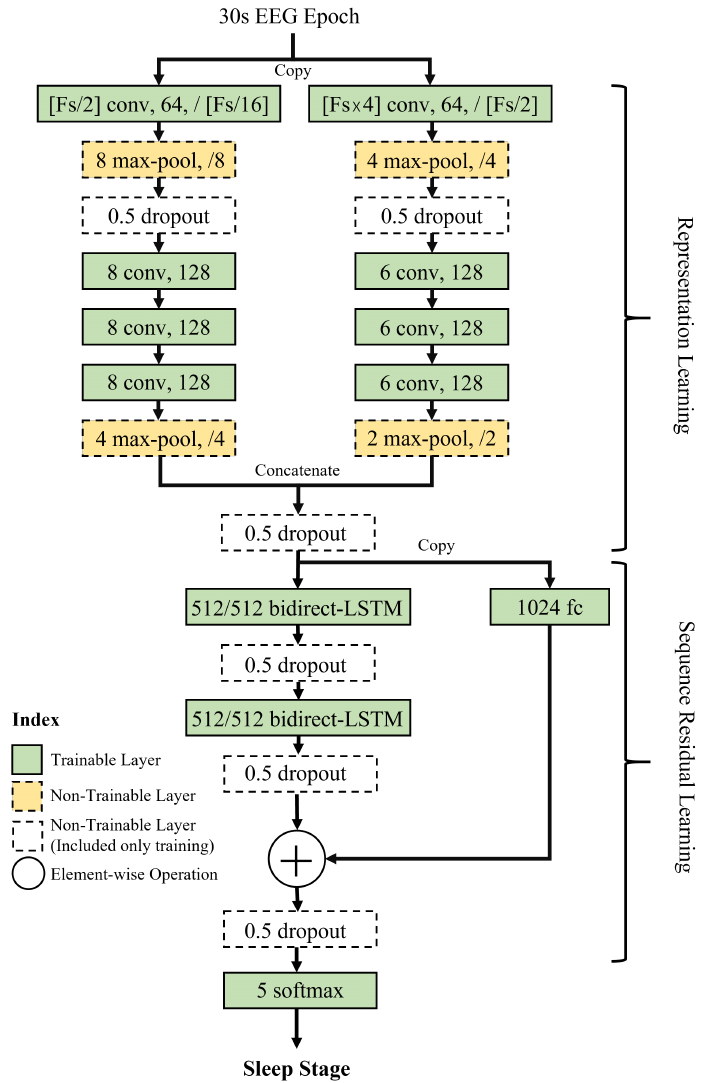
Figure 5. Architecture of the DeepSleepNet. It has two different learning parts such as the CNN and LSTM. The CNN layer proceeds the representation learning and LSTM proceeds the sequence residual learning. The EEG sampling rate (Fs) is a specification for the first convolutional layer.This model classifies the five sleep stages, defined by AASM [27] using the 30 s EEG